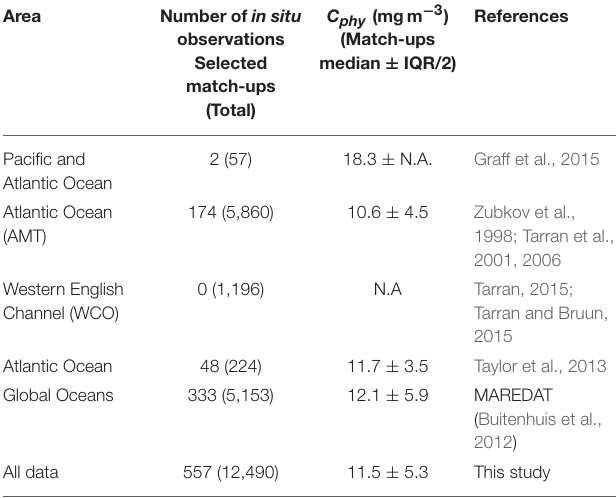
TABLE 1 | Summary of in situ